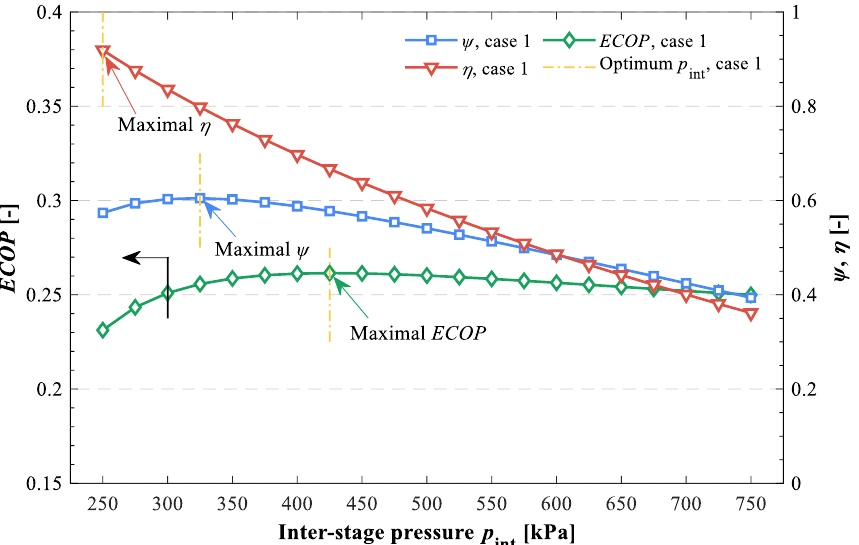
Figure 4. Effect of inter-stage pressure on performance indicators for two-stage cycle with thermal and mechanical compression processes in case 1.